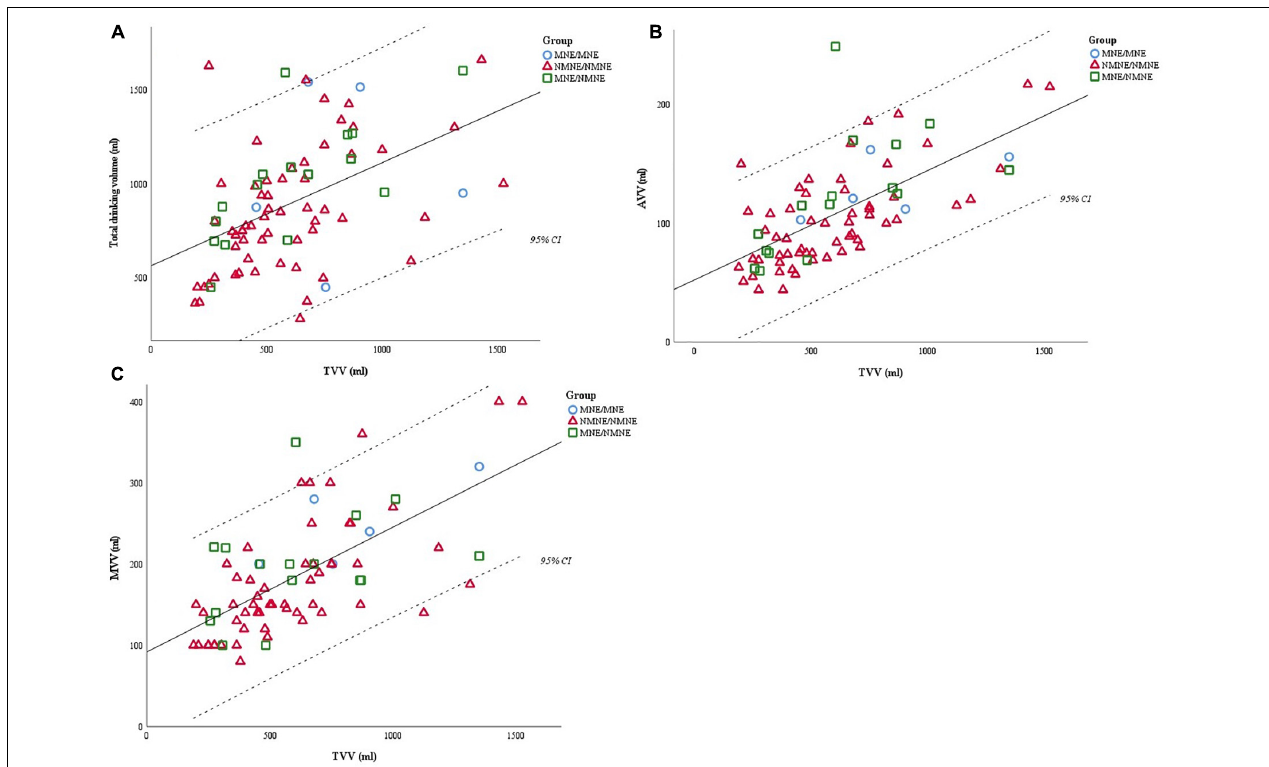
FIGURE 2 | (A) Total drinking volume has a positive moderate correlation to the total voided volume (TVV); ( R = 0.485, p < 0.001). (B) AVV (average voided volume) has a positive high correlation to the total voided volume (TVV); ( R = 0.656, p < 0.001). (C) MVV has a positive high correlation to the total voided volume (TVV); ( R = 0.656, p < 0.001). Total drinking volume is correlated with total voided volume (TVV), with the latter further correlating with the average voided volume (AVV) and maximum voided volume (MVV). Thus, we suggest that the registrations in the diary would be more reliable if the fluid intake was optimized before completing the voiding